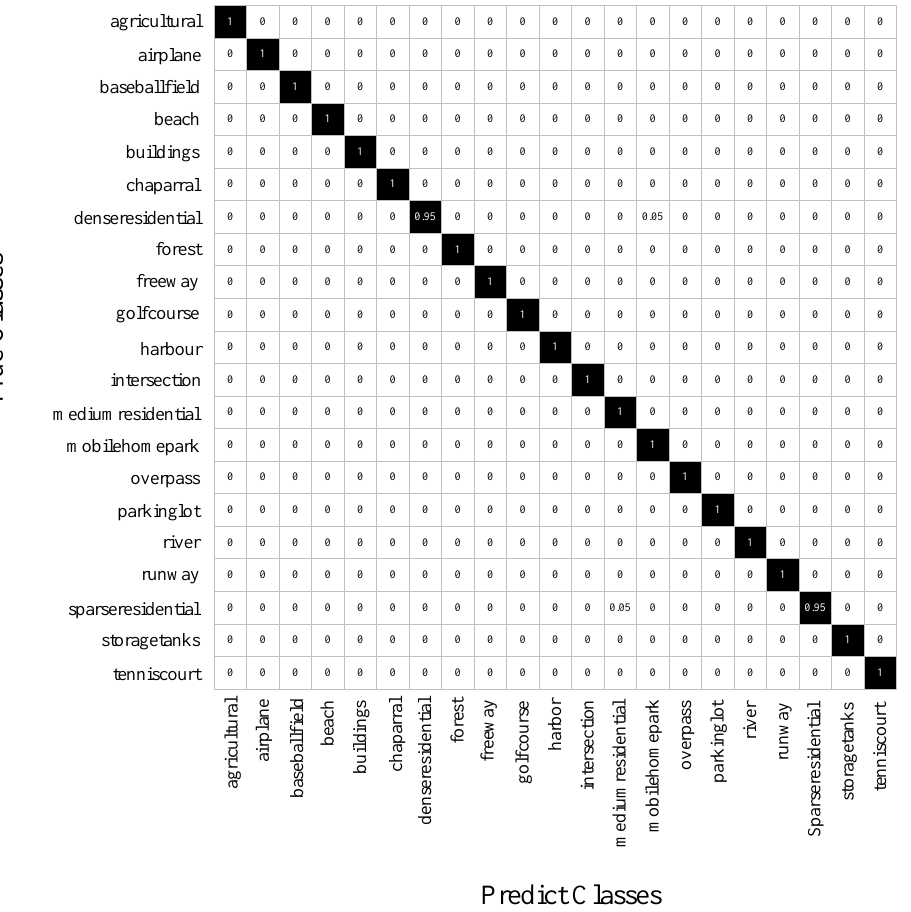
Figure 6. CM on the UCM Land-Use dataset under the training ratio of